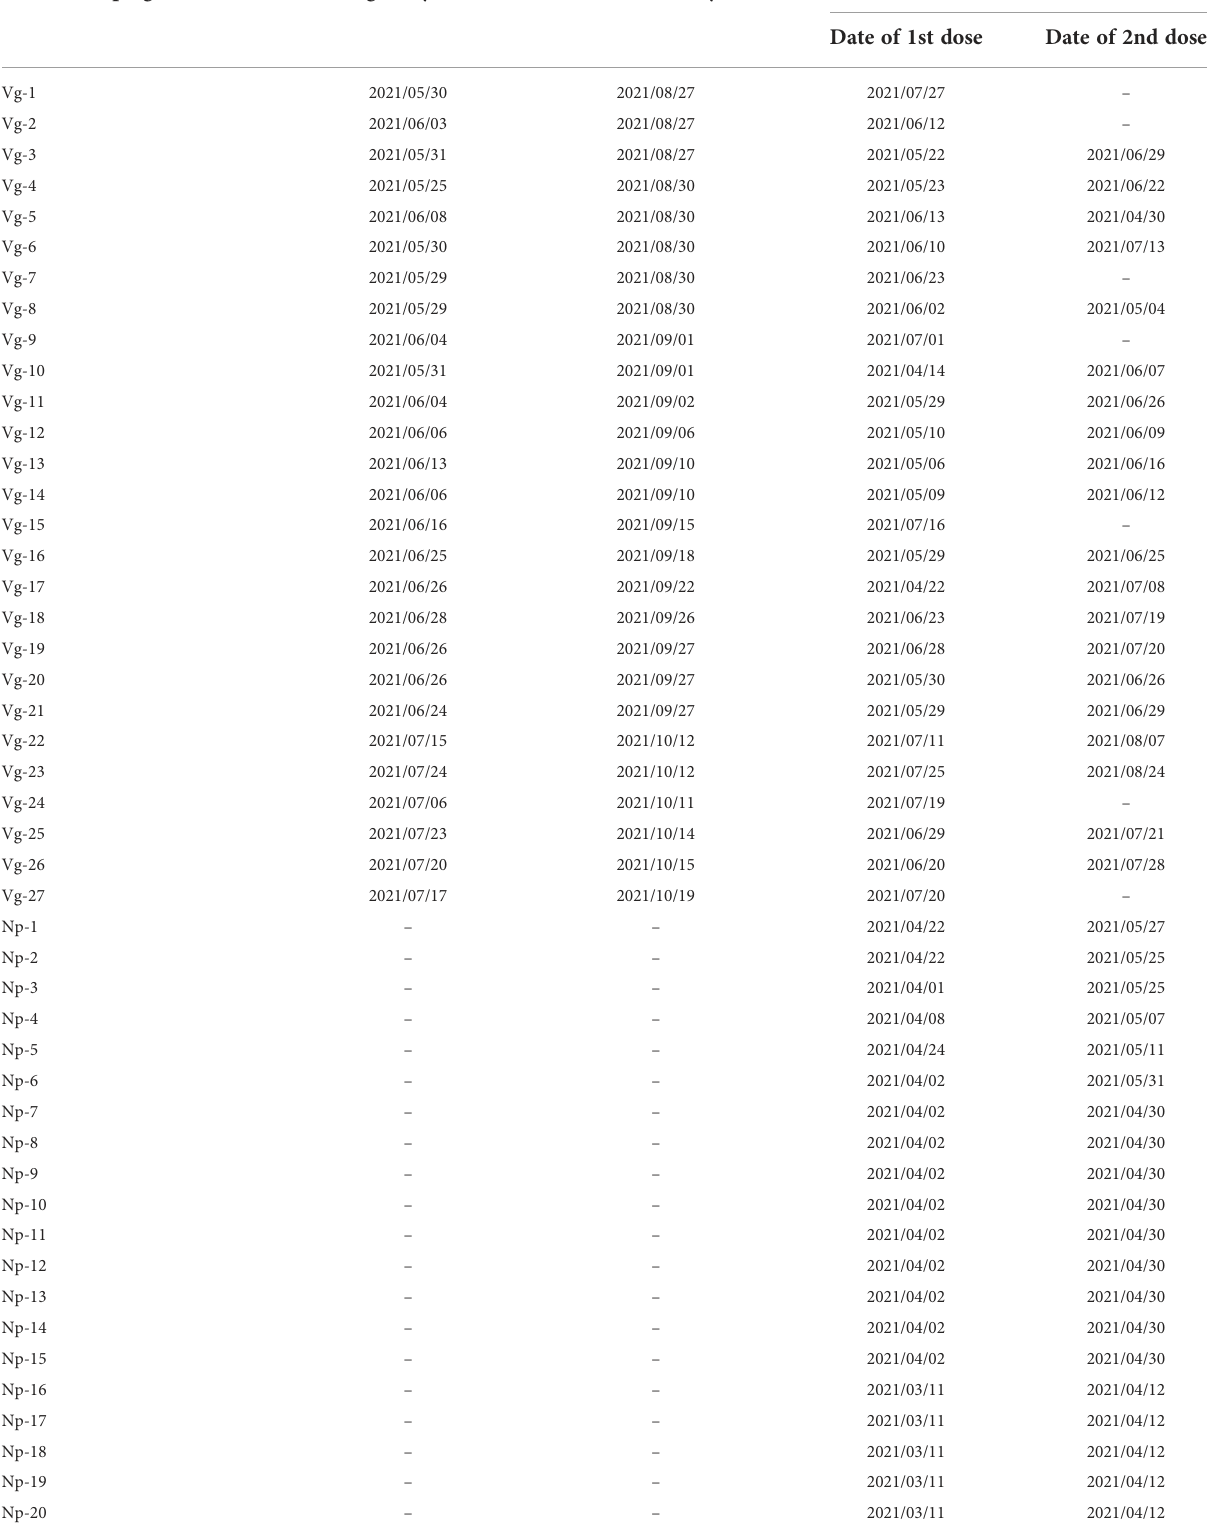
TABLE 2 Scheme of vaccination of vaccinated pregnant women. Vaccinated pregnant